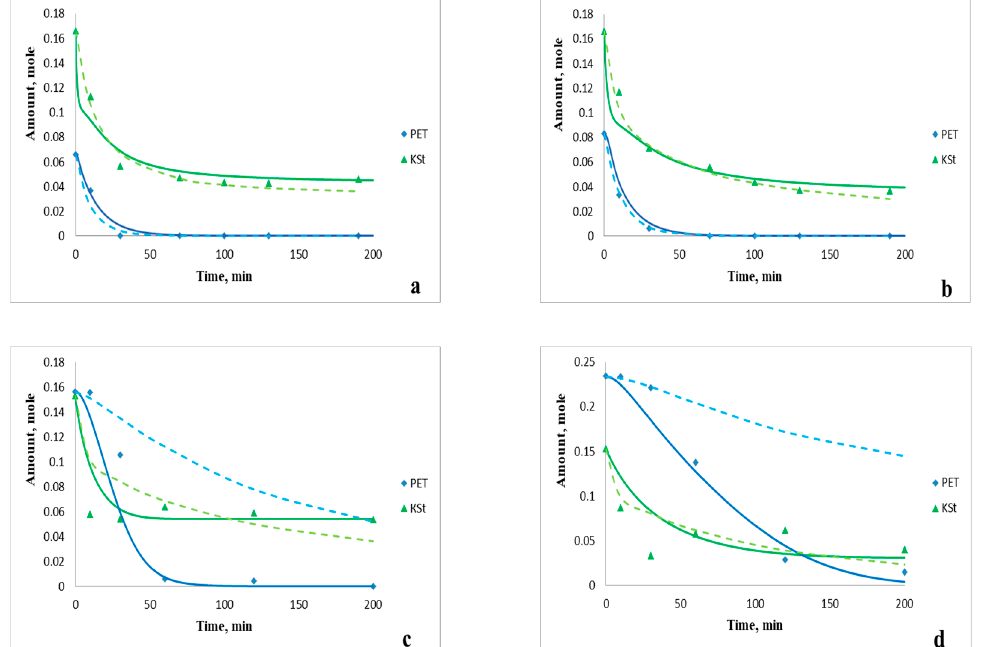
Figure 11. Experimental (dots) and calculated amounts of PET and potassium compounds in crude glycerol according to the previous (dotted) and new (solid) models at different reaction conditions: ( a ) 190 ◦ C PET/KSt = 0.4; ( b ) 190 ◦ C PET/KSt = 0.5; ( c ) 190 ◦ C PET/KSt = 1.0; ( d ) 190 ◦ C PET/KSt = 1.5.